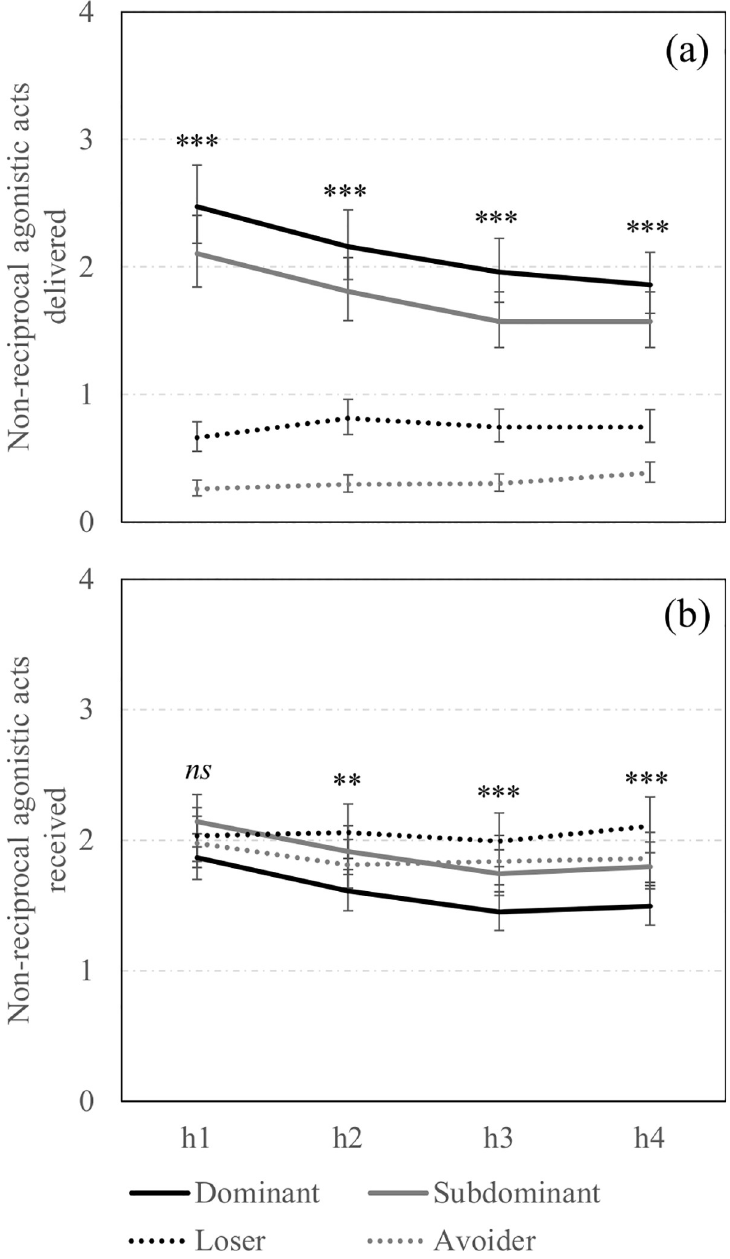
Fig 1. Non-reciprocal agonistic acts across hours on mixing day according to social status. Back-transformed predicted mean [CI] of total non-reciprocal agonistic acts (i.e., bites and knocks, threats, bullying) (a) delivered and (b) received on mixing day across observation hours (h1, h2, h3, h4) and according to the social status (Dominant: Solid black line; Subdominant: Solid grey line; Loser: Dotted black line; Avoider: Sotted grey line). �� , ��� ; Means differ significantly ( �� P < 0.010, ��� P < 0.001); † Means tend to differ ( P < 0.10) between social statuses for a same observation hour. independently of the observation hour. New sows were involved in 0.88 [0.83;0.94] and Resi- dent sows in 0.67 [0.63;0.70] fights per hour on mixing day ( F = 64.9, P < 0.0001), inde- 1,3753 pendently of the observation hour.